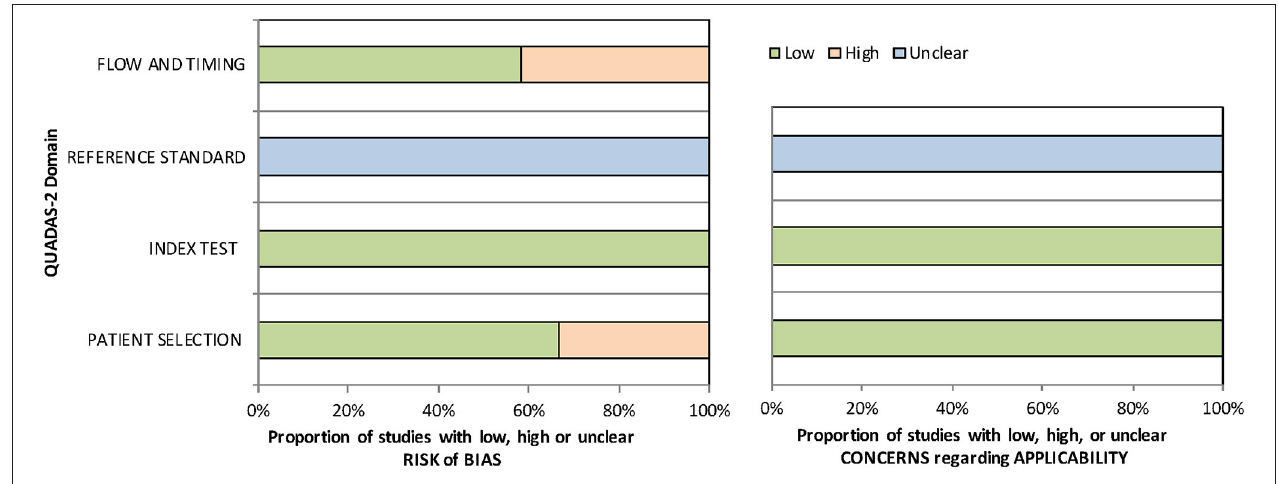
FIGURE 2 | QUADAS-2 quality assessment of the included studies.